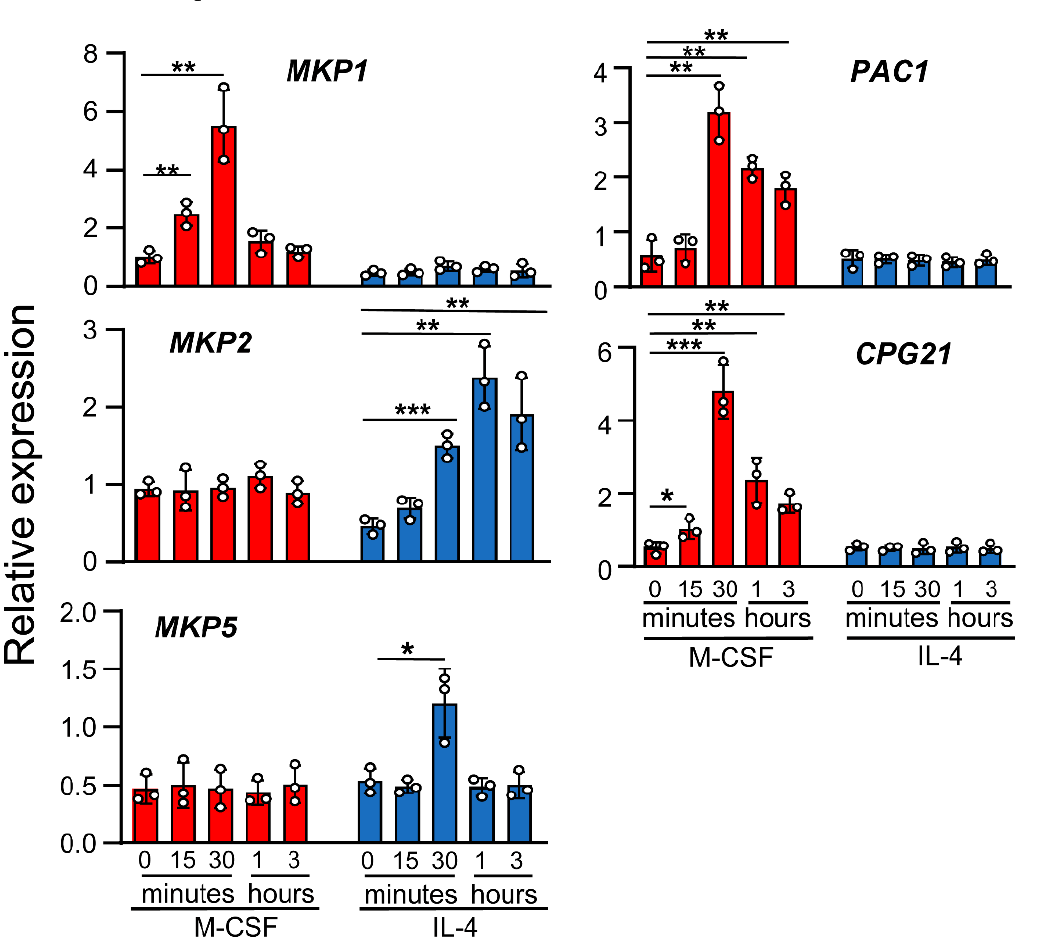
Figure 2. Effects of IL-4 on MKP expression. Macrophages were treated with M-CSF (control) or IL-4 for the indicated periods of time. MKP expression was analyzed by qPCR. The results are shown as the mean ± SD of 3 independent experiments. * p < 0.05, ** p < 0.01, and *** p < 0.001 in relation to the corresponding treatments after all the independent experiments had been compared. Data were analyzed using Student’s t -test.